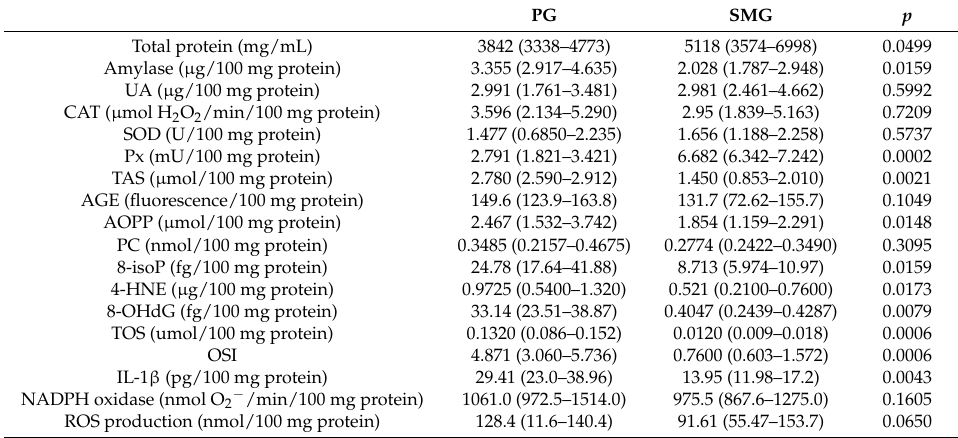
Table 2. Differences between submandibular and parotid glands of the control rats.